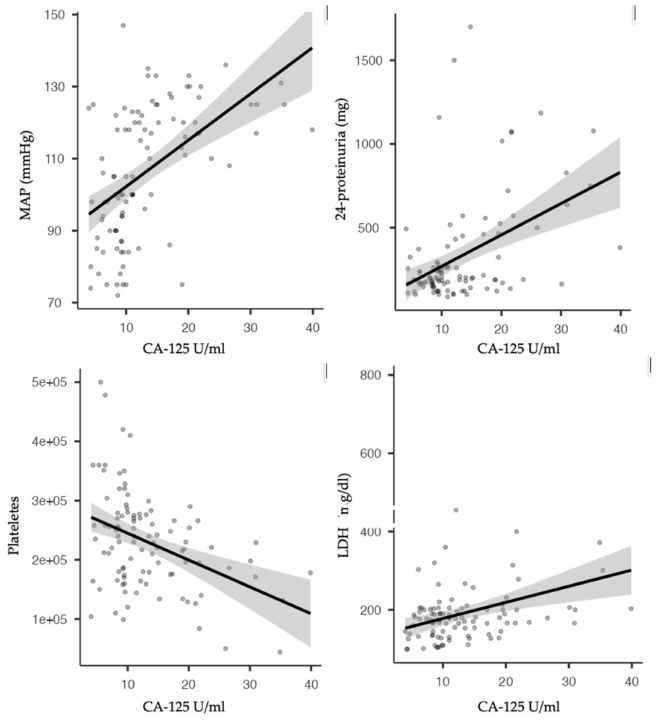
Figure 2. CA-125 correlation with MAP, 24 h proteinuria, platelets count, and LDH.